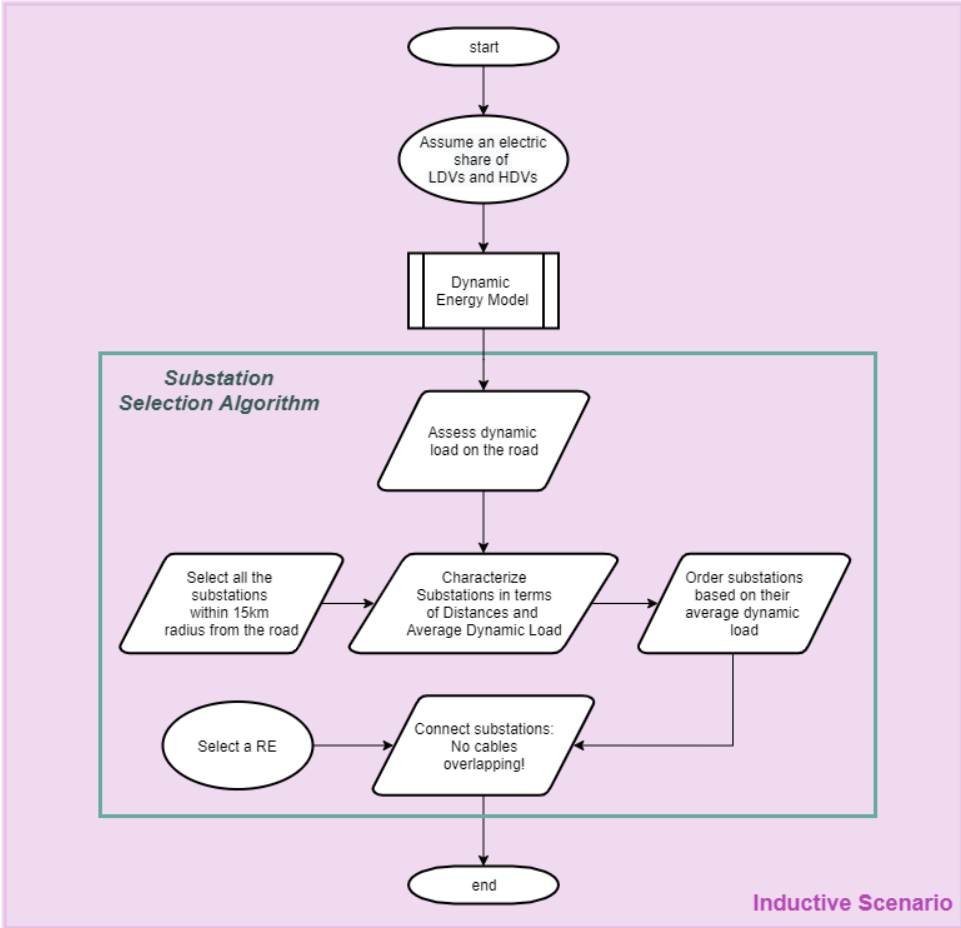
Figure 2. Methodology for the inductive